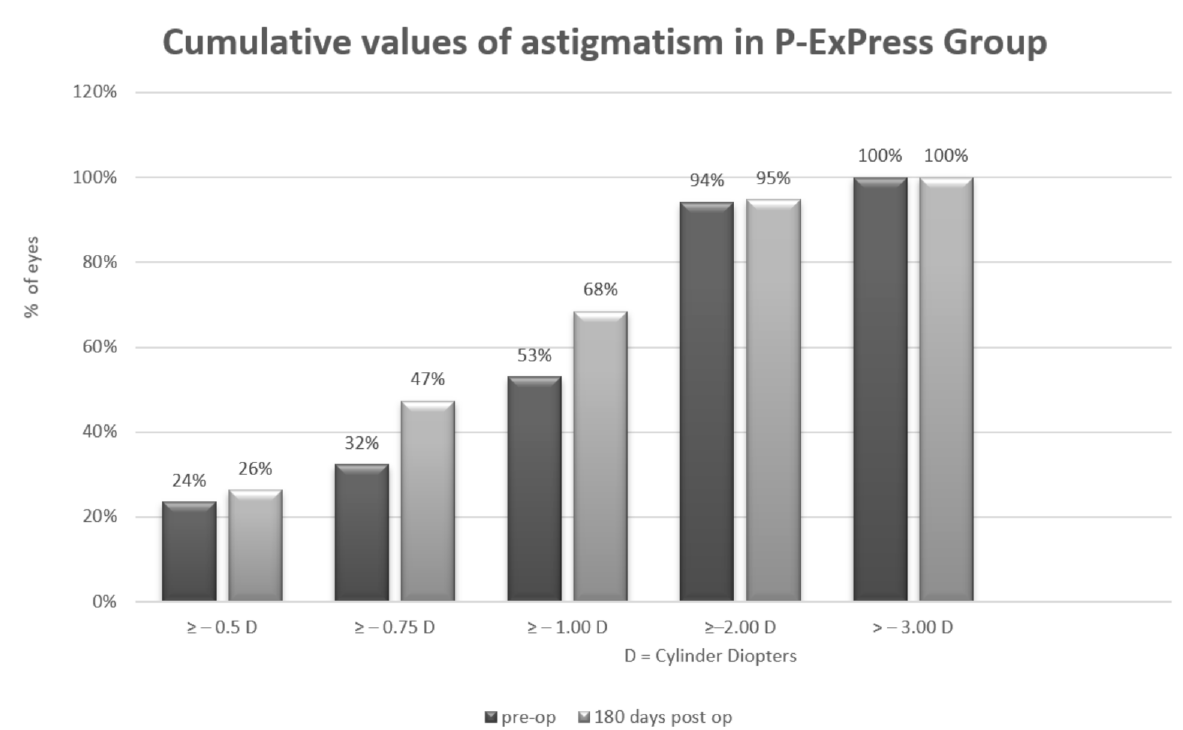
Figure 2. Cumulative values of astigmatism in the P-Ex-PRESS